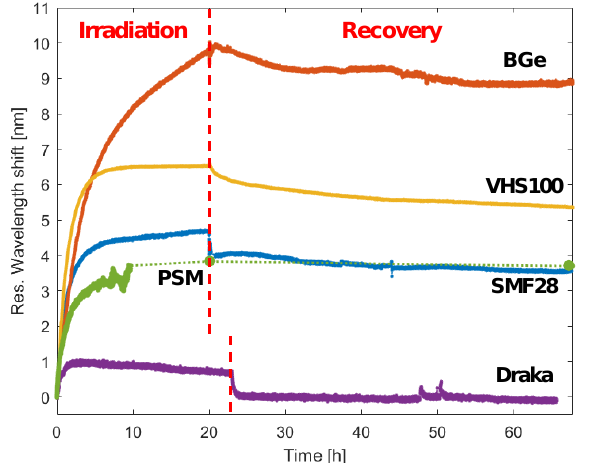
Figure 31. Real-time wavelength shift of LPGs written in several optical fibers, during gamma irradiation and subsequent recovery phase (adapted from Ref. [153]).